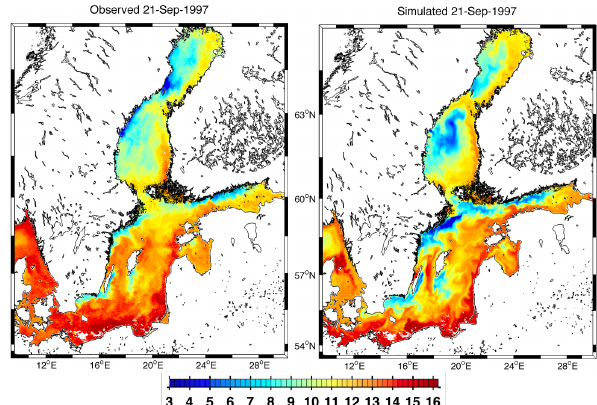
Figure 10. Observed (left panel, weekly composite observed from space, BSH SST; Sect. 3.3) and simulated (right panel, daily mean) sea surface temperature in degrees Celcius. Note that areas of miss- ing observations are flagged white in both the left and right Figure 9. Assessment of simulated sea surface temperature with Fig. 9. Assessment of simulated sea surface temperature with weekly composites observed weekly composites observed from space throughout 1990 to 1999 from space throughout 1990 to 1999 (BSH SST, Sect. 3.3). The color shows the variance (BSH SST, Sect. 3.3). The colour scheme shows the variance ex- explained by the model in units %. plained by the model in units of percent.